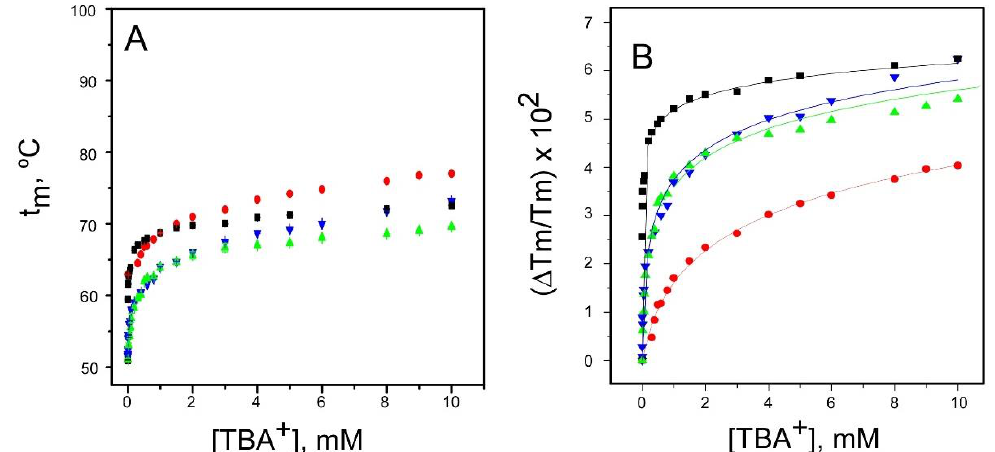
Figure 2. TBA + binding to the resting and inactivated models of the KcsA channel. Thermal denaturation of DDM-solubilized KcsA was recorded in the presence of increasing concentrations of TBA + by monitoring the temperature dependence of the protein intrinsic fluorescence. The midpoint temperature of the denaturation process (t m ) at each TBA + concentration was calculated from the thermal denaturation curves and plotted versus the TBA + concentration. Panel A shows the results obtained from the resting KcsA channel (WT pH 7 ( ■ ) and from the three inactivated channel models (WT pH 4 (●); 1–125 ( ▲ ) and OPEN ( ▼ ) KcsA). All TBA + titrations started with the channel proteins at a 1 µM concentration in either 20 mM Hepes (pH 7.0) or 10 mM succinic acid (pH 4.0) buffers, both containing 5 mM DDM and 1.5 mM NaCl. Here, as well as in all t m vs cation concentration plots in Figures 2–8, the experimental results are the average t m (in Celsius) ± SD at each cation concentration from three to four independent titrations. The term “independent” denotes that the samples were prepared from different protein stocks and the titrations were carried out on different days. Panel B illustrates the fitting of the average Tm (in kelvins) experimental data from panel A to the theoretical function given in Equation (1). The apparent dissociation constants estimated for the WT pH 7, WT pH 4, and the 1–125 and OPEN KcsA channels were 5 × (2.8–8.9) × 10 − 9 , 3.5 × (2.9–4.3) × 10 − 4 M, 1.7 × (1.3–2.3) × 10 − 5 M and 1.7 × (1.2–2.5) × 10 − 5 M, respectively. In parentheses are the confidence intervals (CIs), using a percentage of confidence of 95%.